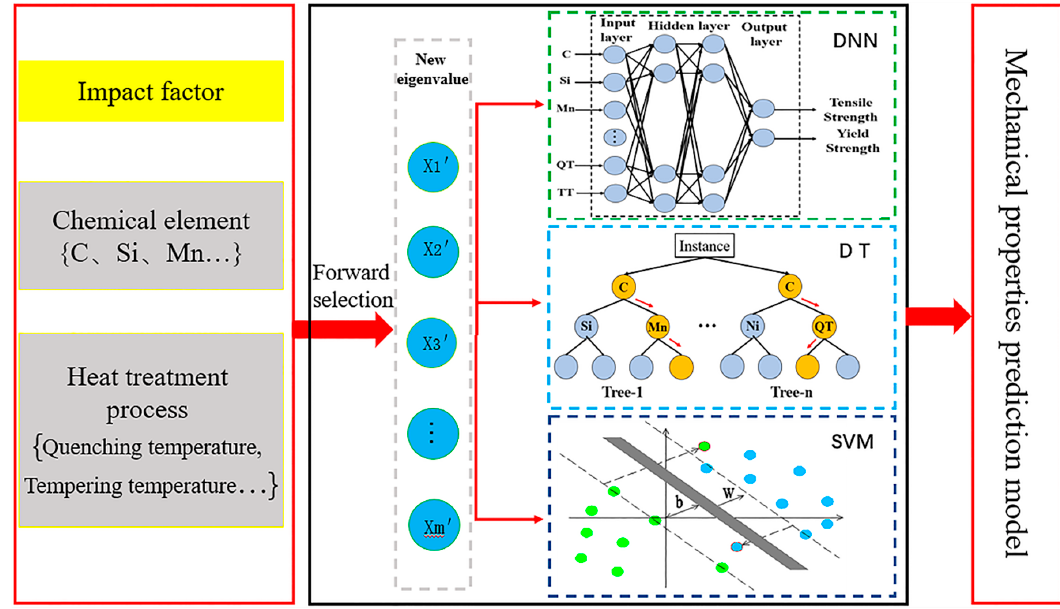
Figure 3. Mechanical properties prediction model.